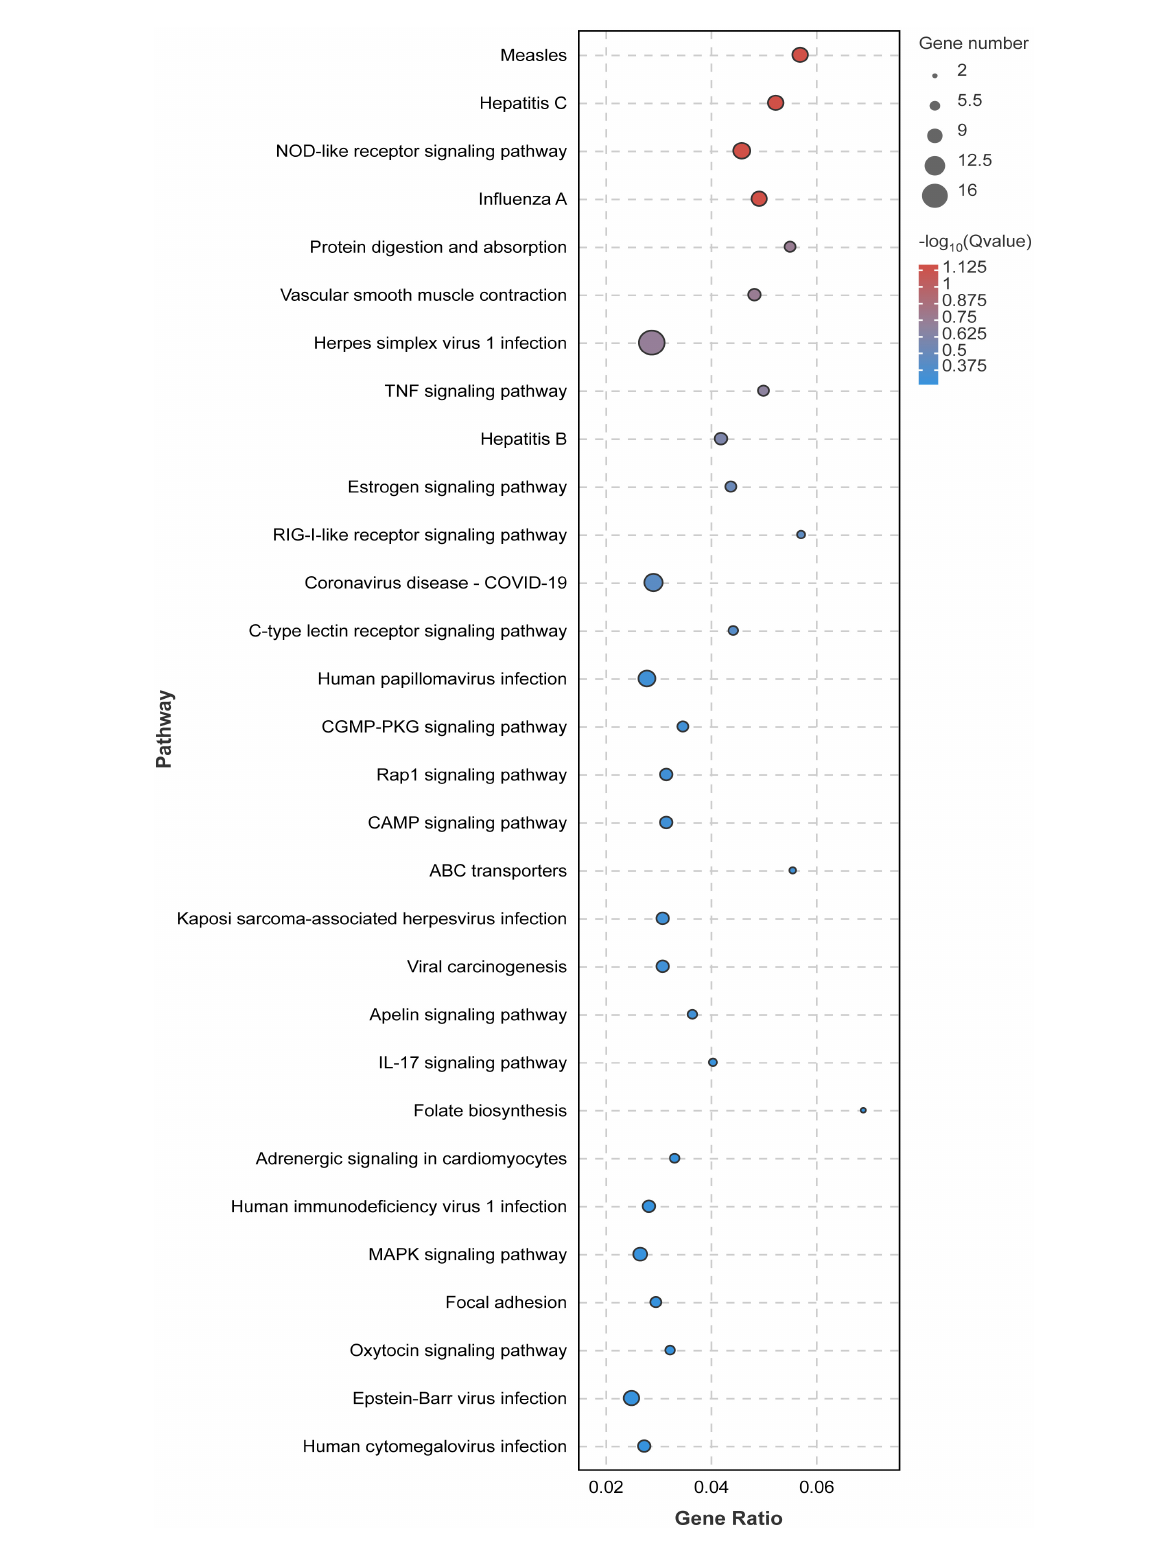
FIGURE6 Significant bubble diagram for top thirty enrichment in the KEGG pathway. Rich factor is the ratio of the DEGs number to the background number in the certain pathway. The size of the dots represents the number of genes, and the dots represents the range of the q -value. C represents three untreated control samples; CH represents three chlorantraniliprole-treated treatment group